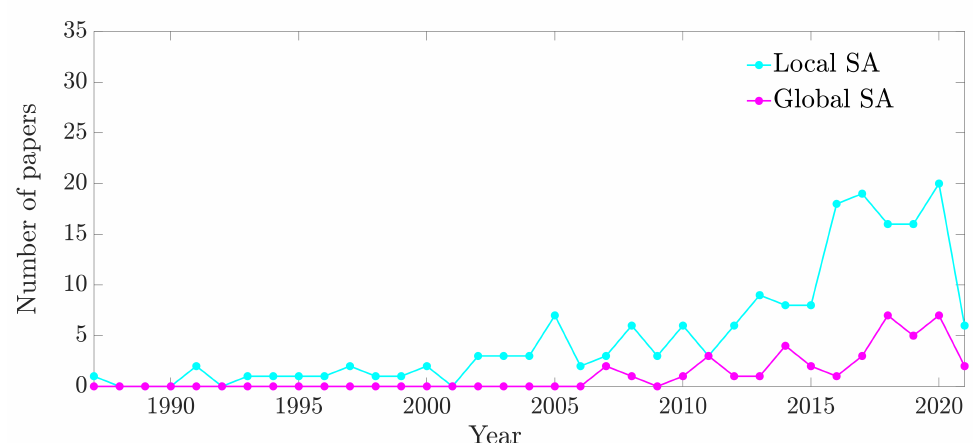
Figure 7. Time evolution of papers featuring local and global SA methods (cyan and magenta line,